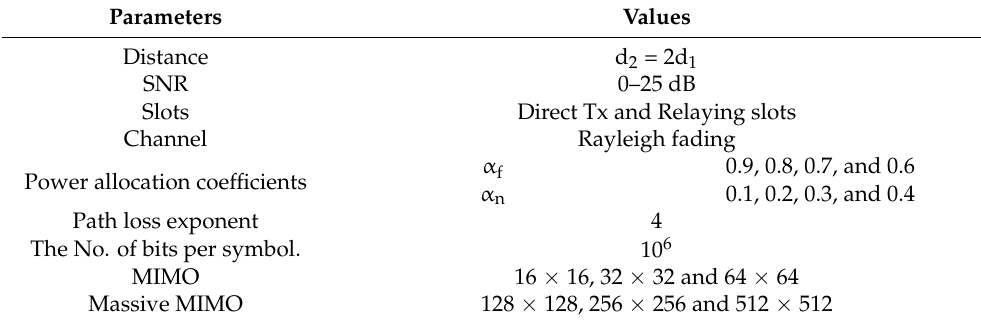
Table 1. Simulation